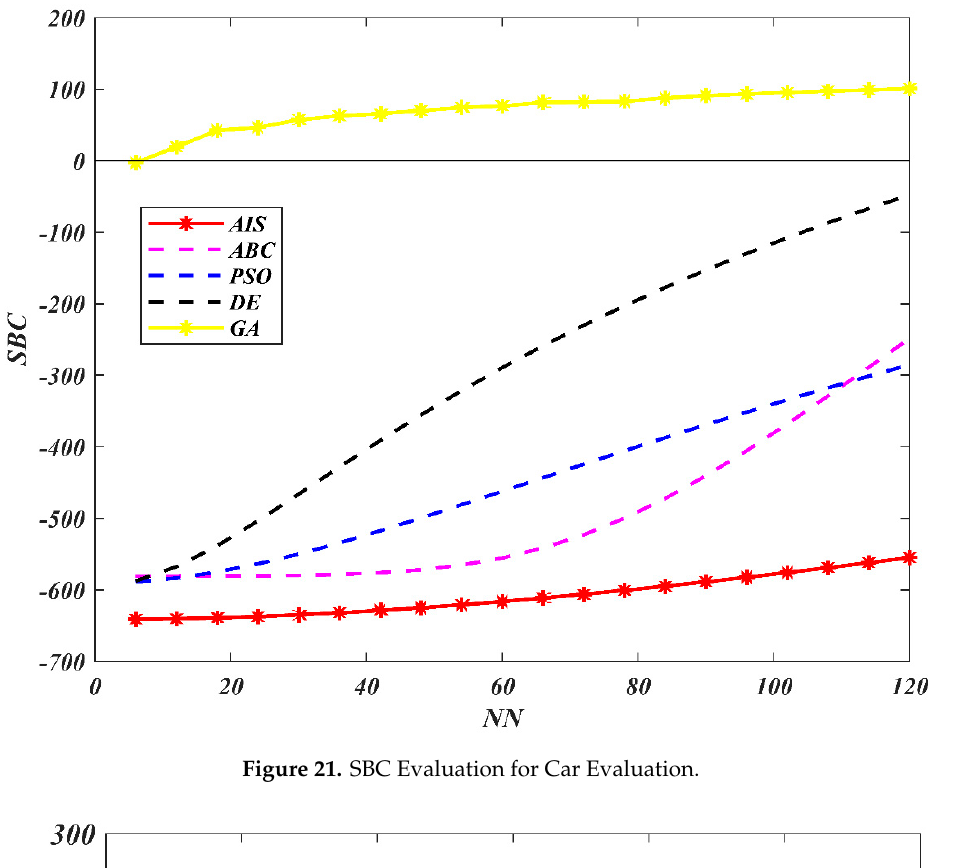
Figure 20. SBC Evaluation for Congressional Voting Records.